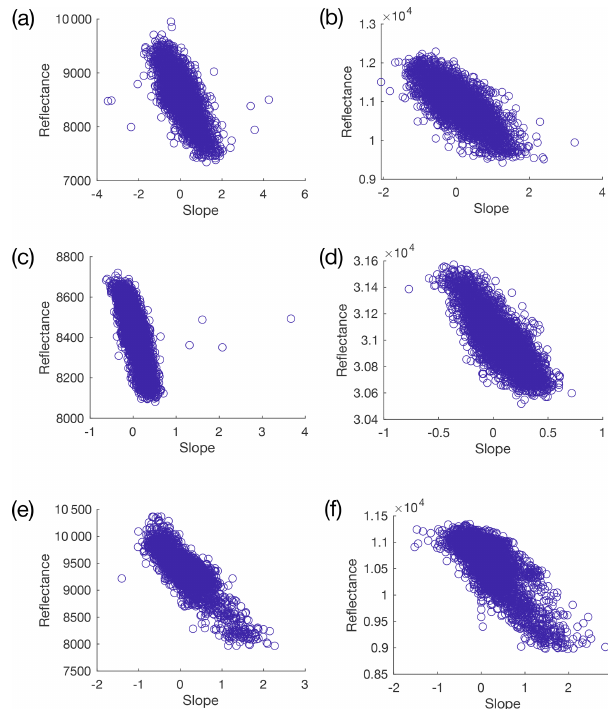
Figure A1. Plots of slope vs. Landsat 8 red-band reflectance for areas outside of the lake and buffer zone for each of the Landsat 8 images analysed for the photoclinometry portion of this study. The plots are laid out as follows: (a) Lake 2 Before, (b) Lake 2 After, (c) Lake 5 Before, (d) Lake 5 After, (e) Lake 6 Before and (f) Lake 6 After.